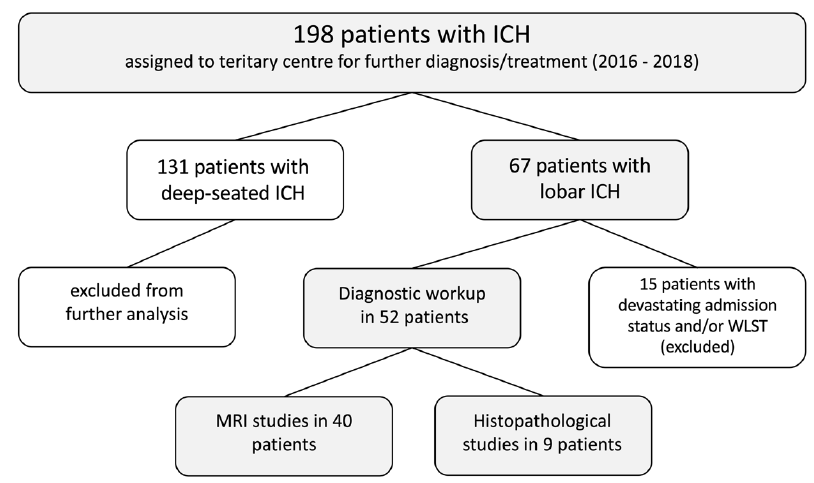
Figure 1. Patient enrollment. ICH = intracerebral hemorrhage; WLST = withdrawal of life-sustaining therapy; MRI = magnetic resonance imaging.